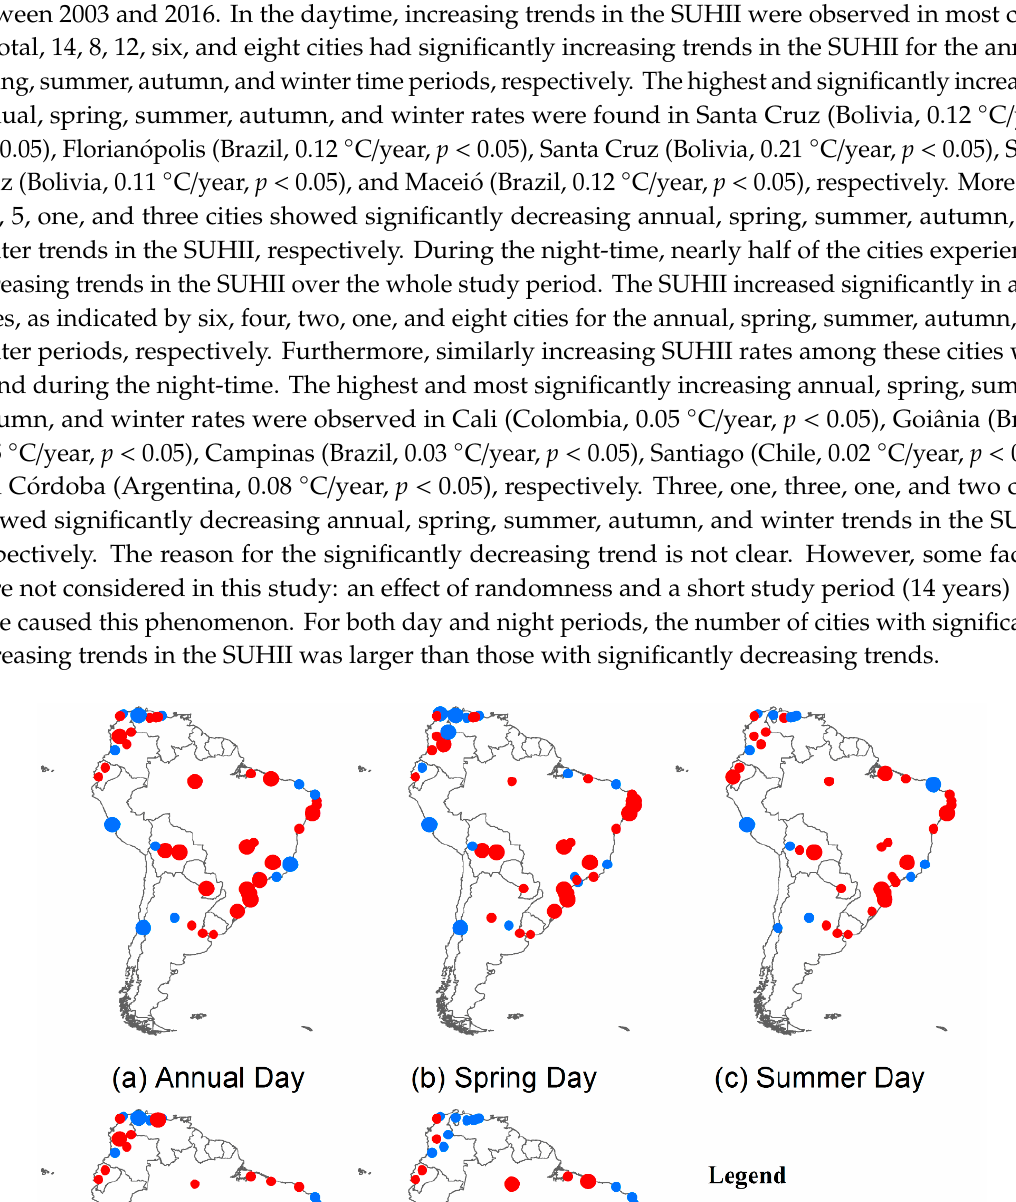
Figure 6. Temporal trends in the night-time SUHIIs for each city from 2003 to 2016.